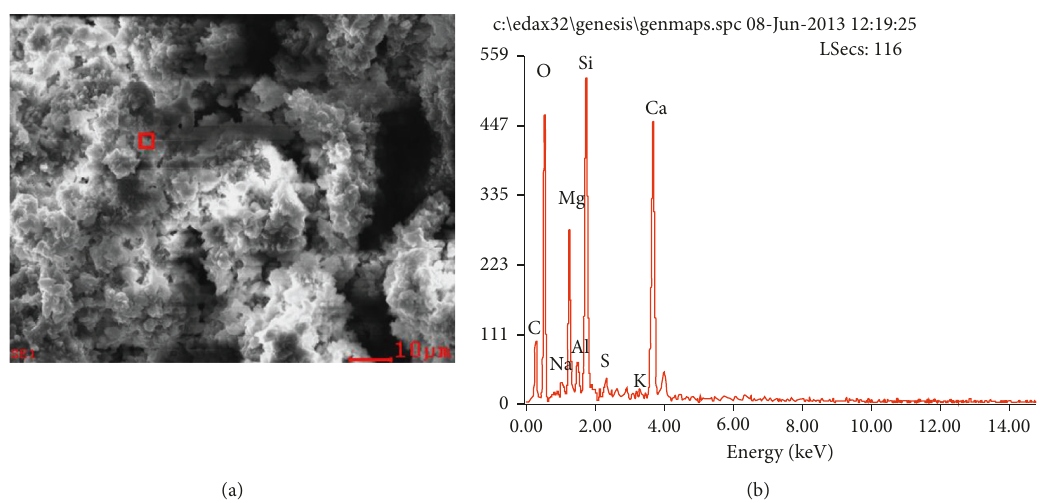
Figure 5: SEM and EDS images of the corroded concrete. (a) SEM; (b) EDS.